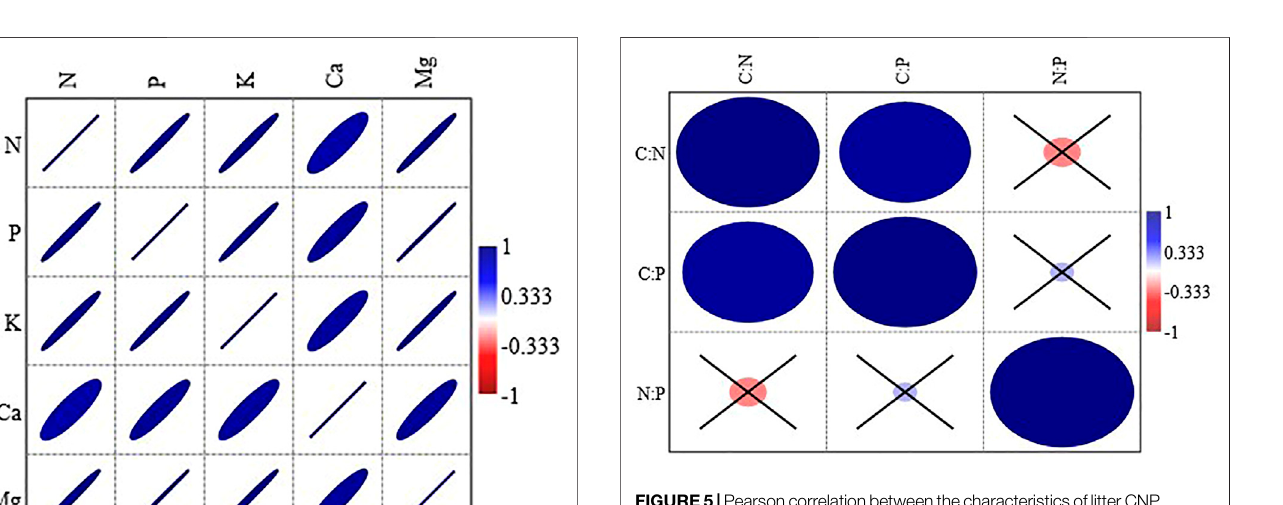
Frontiers in Environmental Science |